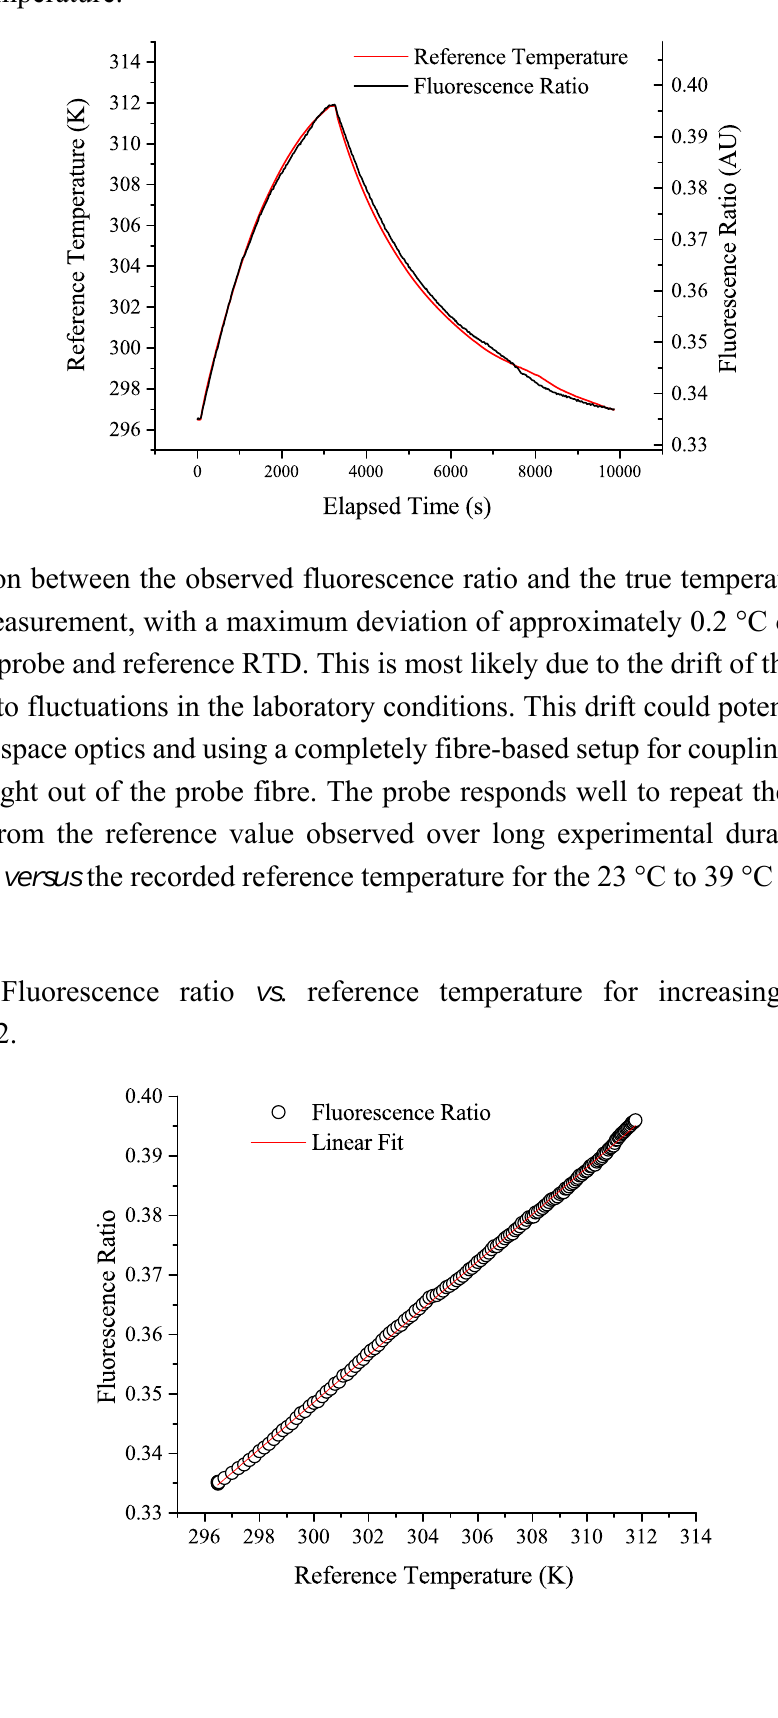
Figure 5. Erbium ytterbium-doped multi-mode fibre response with a co-located fibre probe (black) and reference resistance temperature detector (RTD) (red) inside an incubator. The fluorescence ratio is shown scaled to the maximum and minimum values recorded on the reference temperature.